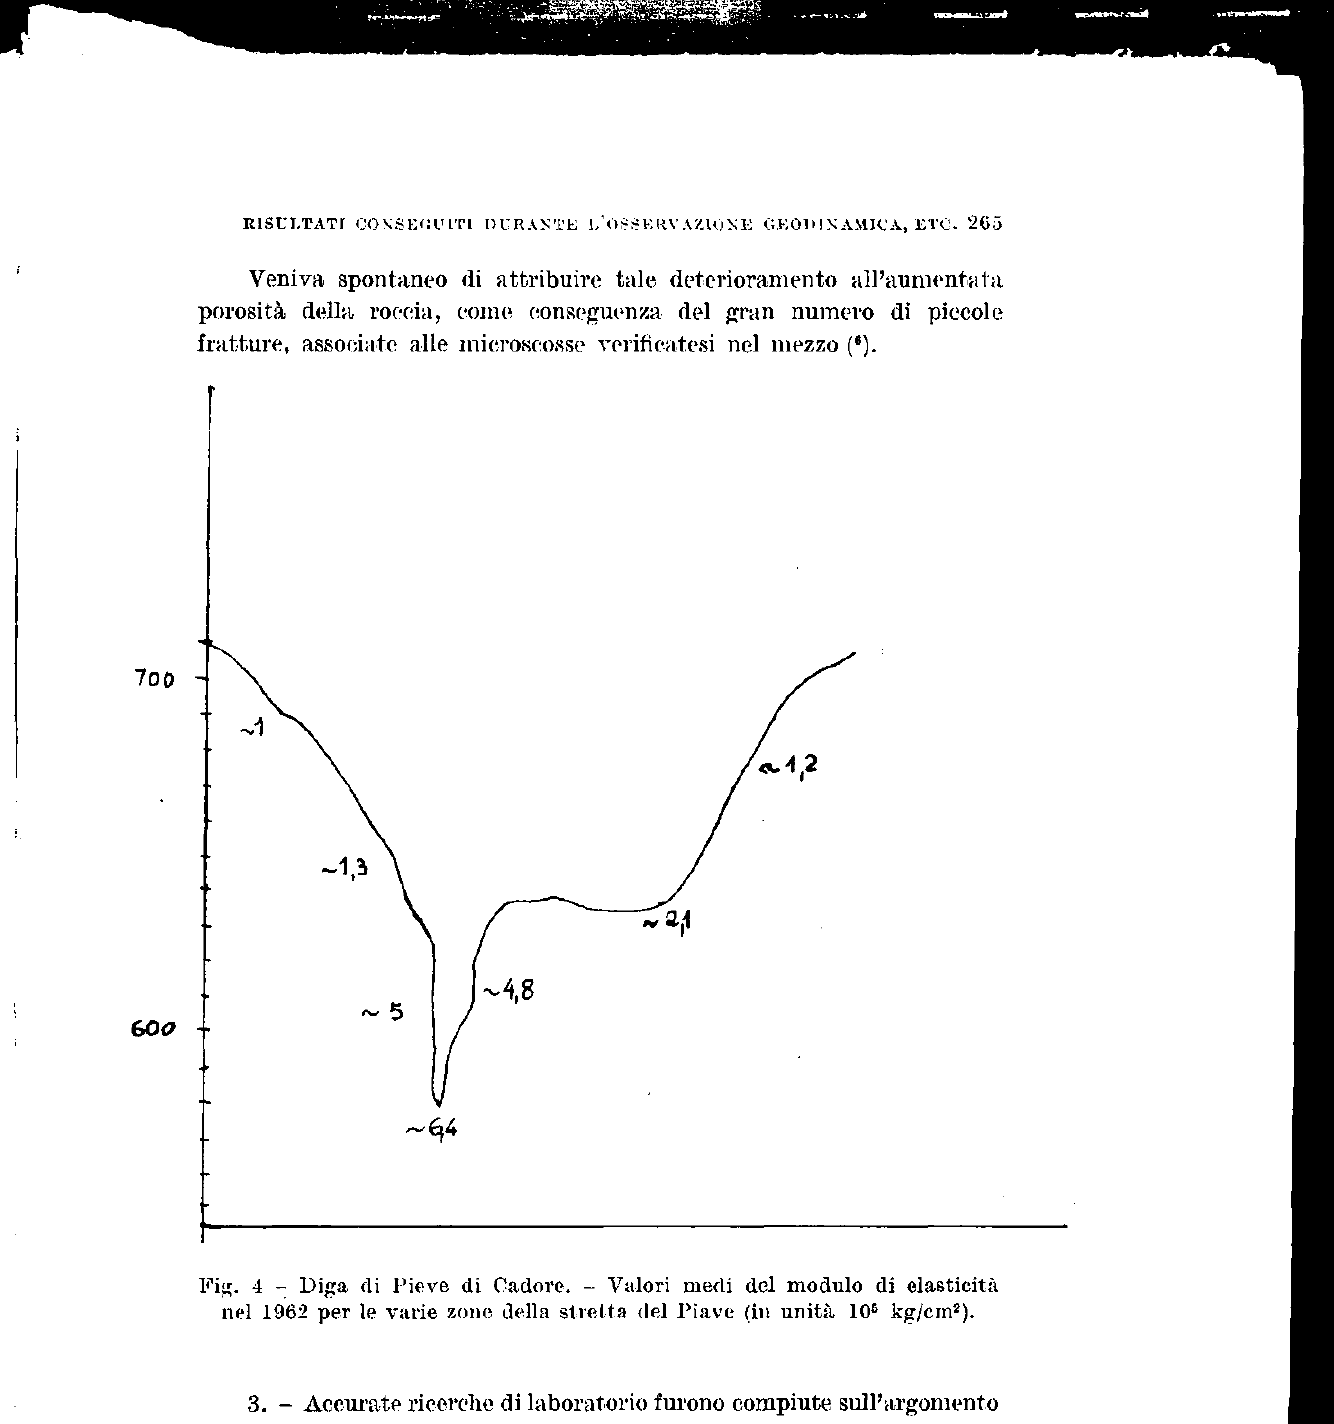
3. - Accurate ricerche di laboratorio furono compiute sull'argomento della porosità e dei problemi